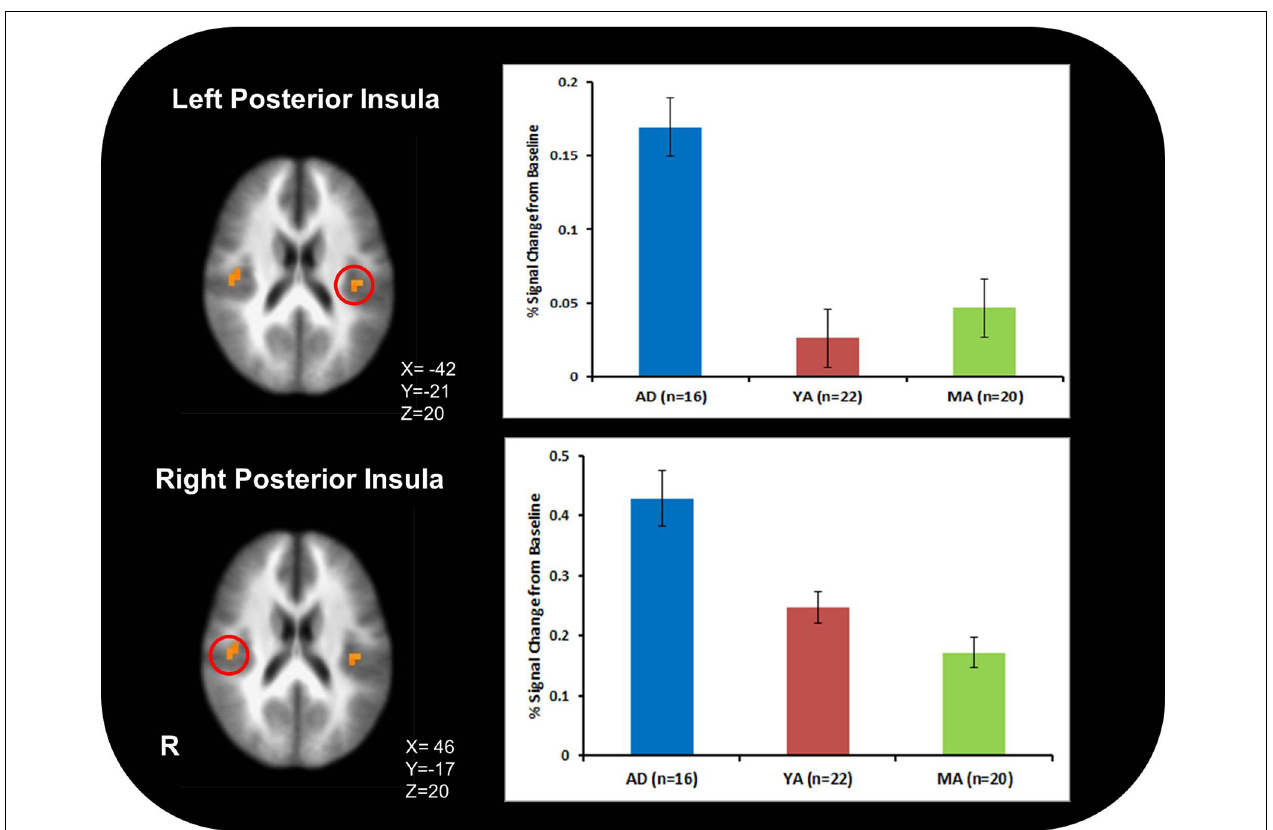
FIGURE 2 | Adolescents (AD) exhibited greater bilateral posterior insula activation than young adults (YA) and mature adults (MA) across all conditions and stimulus